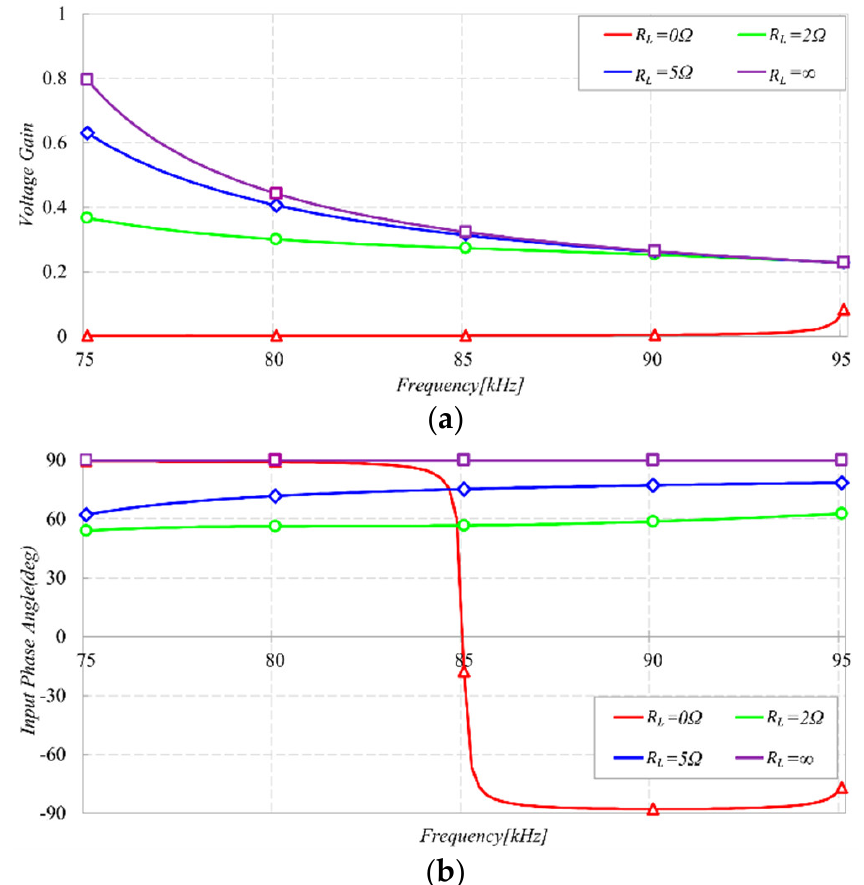
Figure 4. Proposed design methods: ( a ) voltage gain for different load resistances; ( b ) phase angle for different load resistances.